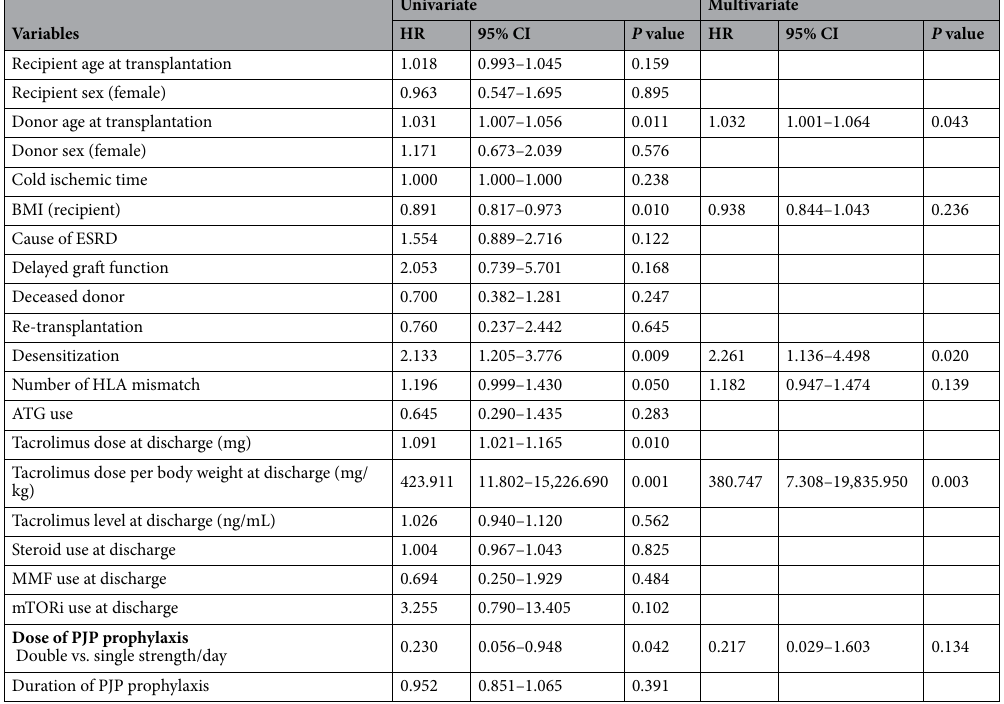
Table 3. Risk factors for Pneumocystis jirovecii pneumonia after kidney transplantation. Multivariate analysis was performed using variables that showed significance of P < 0.10 in univariate analysis. Abbreviations : ATG, anti-thymocyte globulin; BMI, body mass index; CI, confidence interval; ESRD, end stage renal disease; MMF, mycophenolate mofetil; mTORi, mammalian target of rapamycin inhibitor; PJP, pneumocystis jirovecii